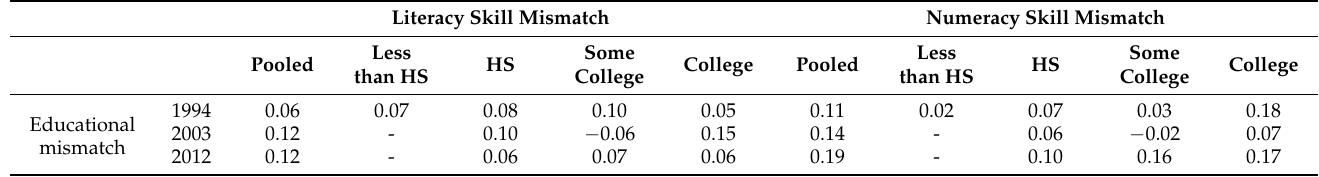
Table 2. Correlation between educational and skill mismatch by educational attainment.